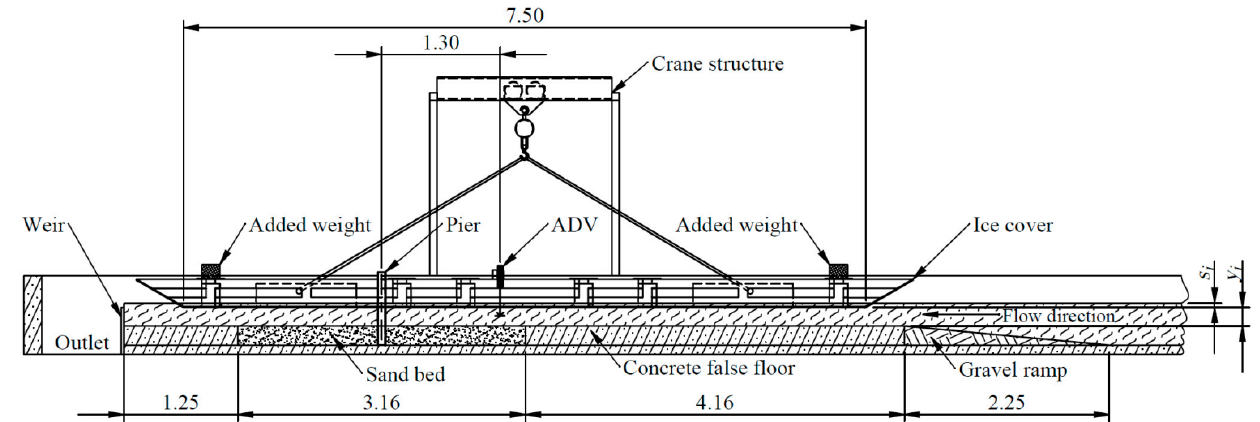
Figure 1. Cross-sectional drawing of the ice cover apparatus installed in the flume (dimensions in m). y i is the flow depth under the ice and s i is the ice cover